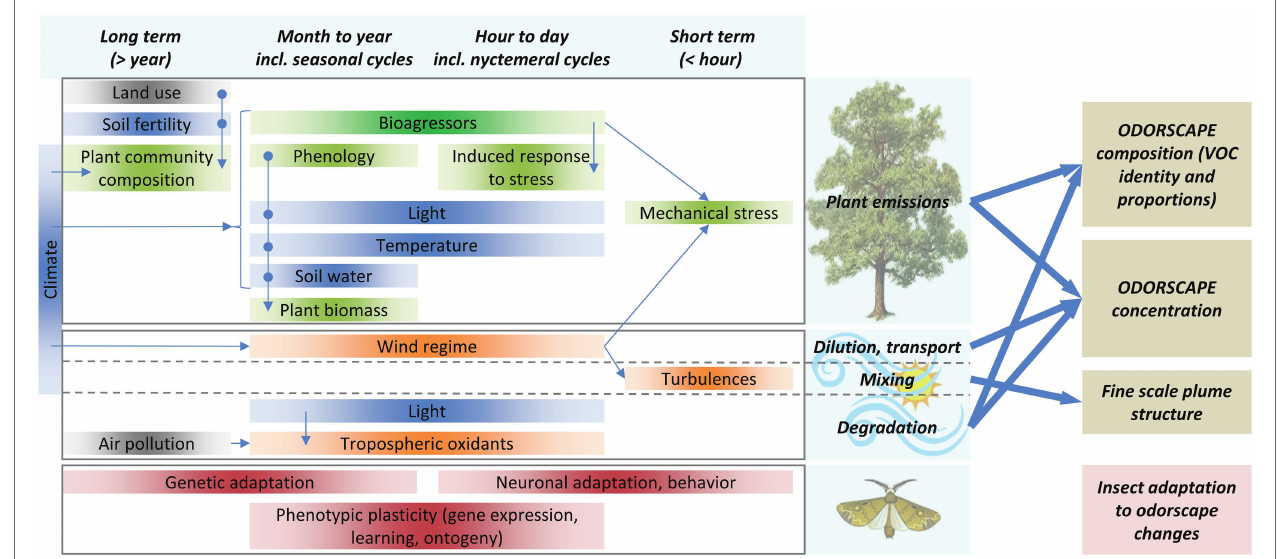
FIGURE 2 | Odorscapes are highly variable at a diversity of time scales. The left part of this chart depicts the factors that determine volatile emissions by plants (top), atmospheric processes (middle), and the processes by which insects can adapt to changes in their olfactory environment (bottom), classified horizontally by the time scale at which they act or vary. Thin arrows depict indirect impacts, through influence on another factor. Box color: dark blue = climate and soil factors, green = plant physiology and ecology, orange = atmospheric physico-chemistry, brown = insect adaptation processes, gray = anthropic factors. Although this is not represented for readability issues, extremes of most climate and soil factors do cause stress responses in plants. VOC sources other than plants (especially anthropogenic VOC) are ignored. On the right side, thick arrows depict how plant emissions and atmospheric processes determine the characteristics of the